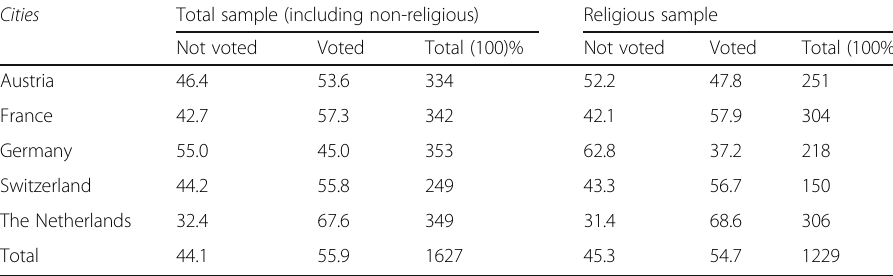
Table 1 Municipality voting distribution of respondents according to